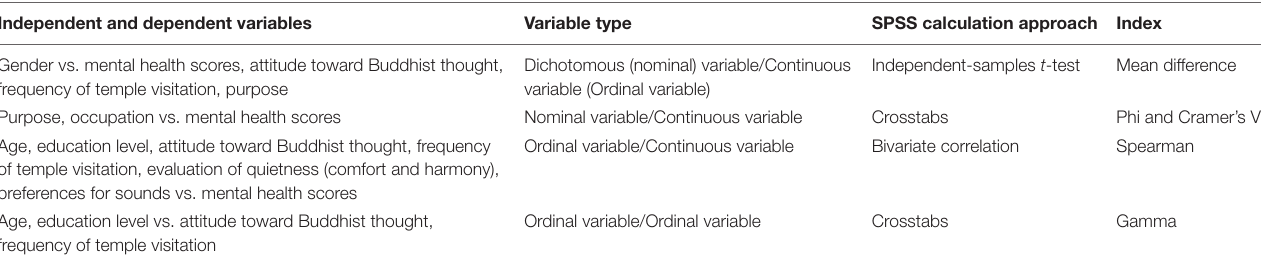
TABLE 2 | The calculation method of independent and dependent variables. Independent and dependent